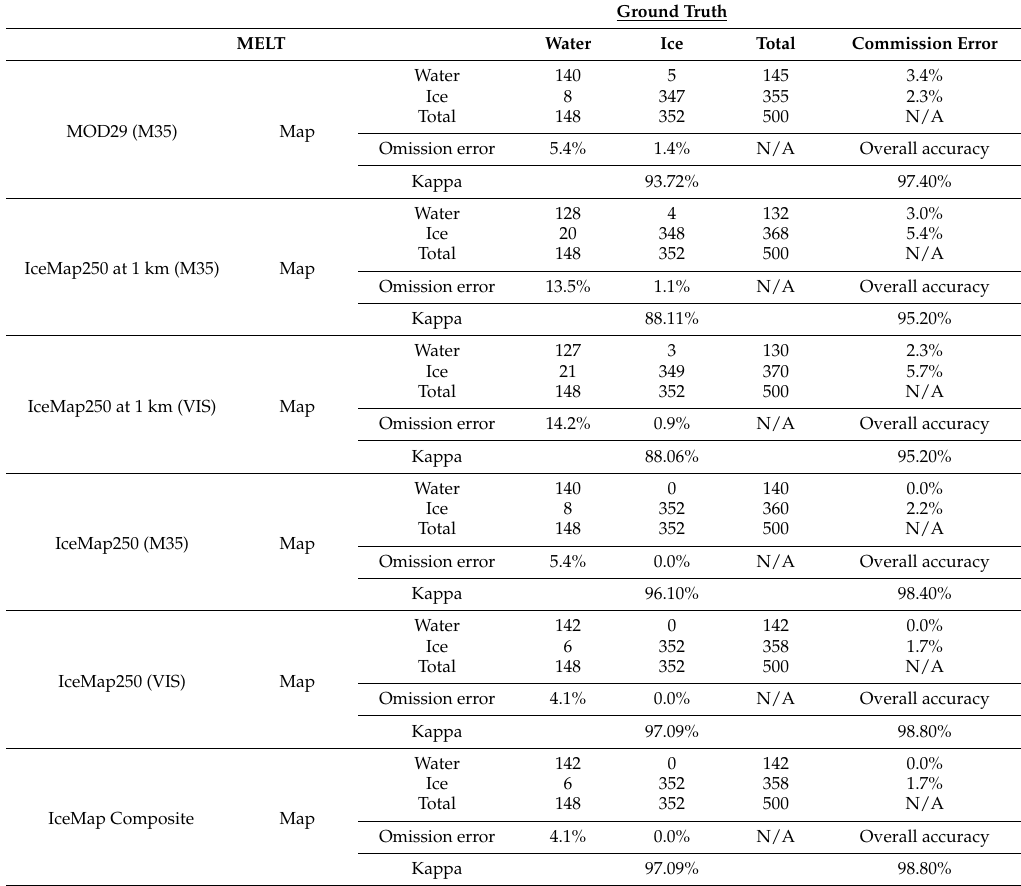
Table 5. Contingency table for the melt period validation (13 June 2013 to 23 June